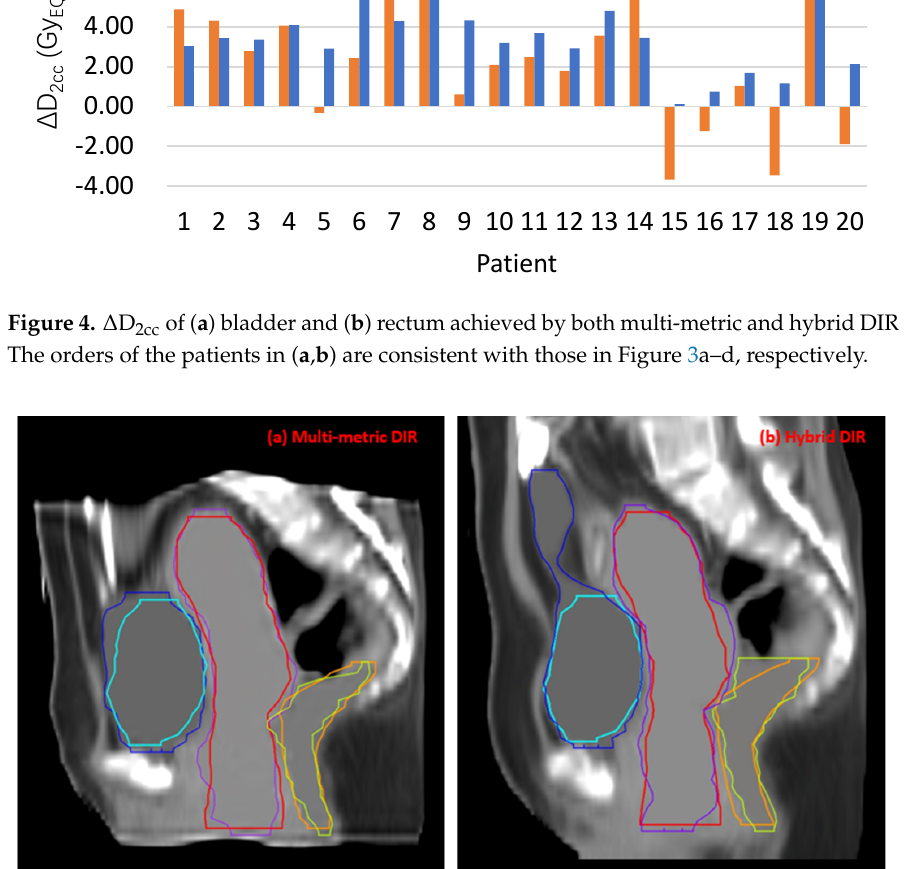
Figure 5. The registration results ( a , b ) achieved by the multi ‐ metric and hybrid DIR methods, re ‐ spectively, and their corresponding accumulated dose distributions ( c , d ) for one patient. The refer ‐ ence bladder, rectum, and U + V are shown in cyan, orange, and red, respectively, and the corre ‐ sponding deformed contours are shown in blue, yellow, and pink, respectively. 4. Discussion Dose accumulation of EBRT and BT is critical to evaluate the total biologic effective dose to targets and OARs for combined cervical cancer radiotherapy. For a more accurate accumulated dose distribution, a multi ‐ metric DIR method based on the Elastix software was employed, which included an intensity ‐ based metric, three contour ‐ based metrics, and a penalty term. Reviewing previous studies, different patient data and methods used for DIR would lead to considerably different results. For example, the mean rectal DSC reported by three studies were 0.75, 0.85, and 0.92, respectively, although they used the same software for DIR [10–12]. Therefore, we did not compare our results with those pub ‐ lished in other literature but rather chose a commercial hybrid DIR method that uses the same metrics as the multi ‐ metric DIR for comparison. The results showed that the multi ‐ metric DIR has higher accuracy than the hybrid DIR. This is mainly because the open ‐ source Elastix software allows users to pick appropriate components and optimize param ‐ eters for a specific registration application. Through grid search, we made the parameter setting of multi ‐ metric DIR more effective in dealing with registration tasks of large and complex organ deformations.